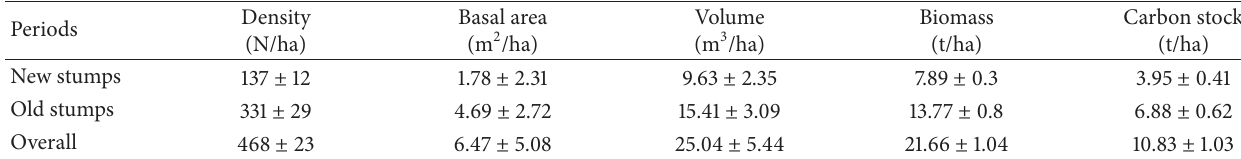
NB: new and old stumps differentiated by local guide based on appearance and experience.